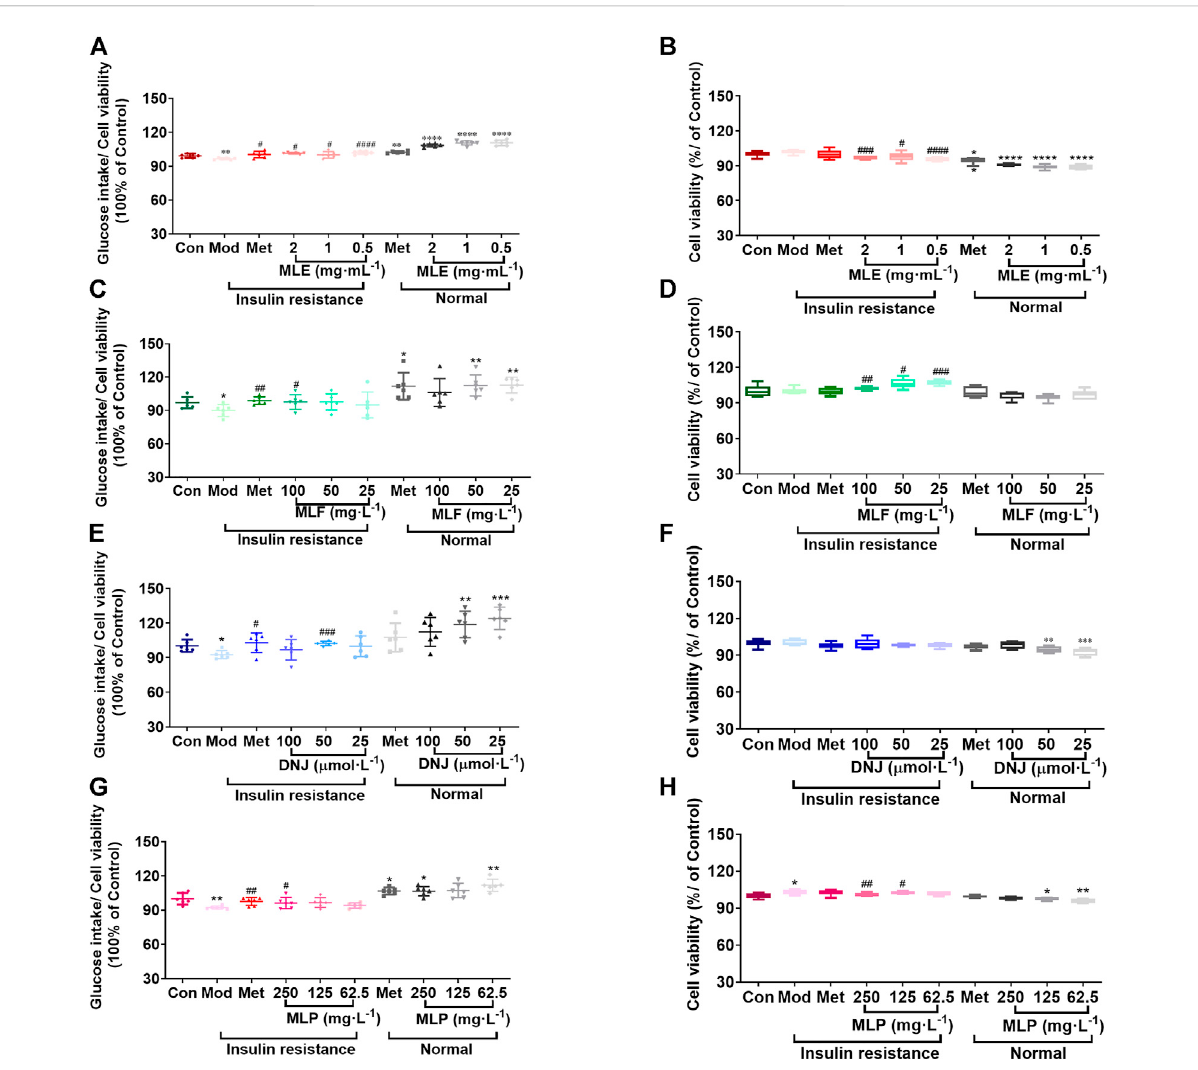
FIGURE 3 MLE, MLF, DNJ, and MLP treatment promotes glucose uptake in insulin-resistant L02 cells. Glucose intake levels in human L02 hepatocytes treatedwithMLE (A) ,MLF (C) ,DNJ (E) andMLP (G) atdifferentdoses.ViabilityofL02hepatocytestreatedwithMLE (B) ,MLF (D) ,DNJ (F) andMLP (H)